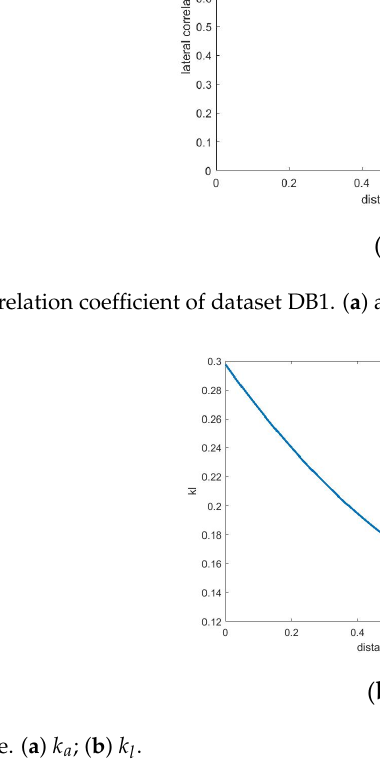
Figure 18. 𝑘𝑘 𝑒𝑒 curve of six datasets.